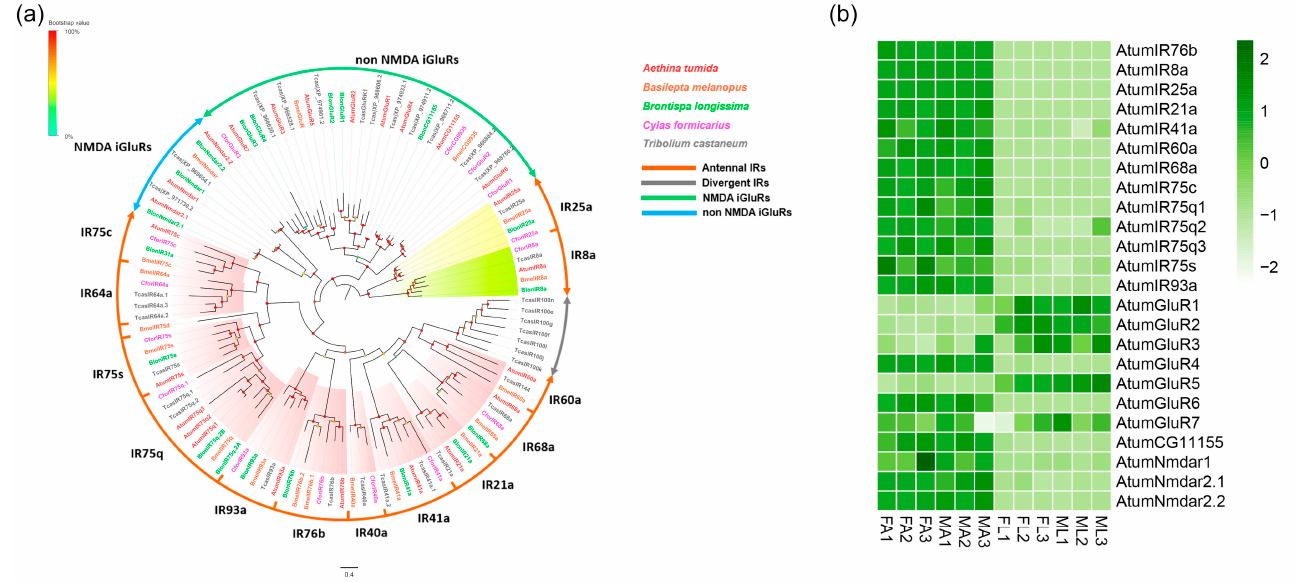
Figure 2. Analyses of putative ionotropic recptors (IRs) in A. tumida . ( a ) Maximum-likelihood tree of putative IRs. The tree was rooted with the conservative IR8a/IR25a orthologues. Circles at the branch nodes represent bootstrap values based on 1000 replicates. Scale bar represents the 0.4 amino acid substitutions per site. Antennal IRs are marked with orange; Divergent IRs are marked with gray; NMDA iGluRs are marked with green; non-NMDA iGluRs are marked with blue. ( b ) Heatmap of IRs based on antennae and forelegs transcriptome data in A. tumida . FA, female antennae; MA, male antennae; ML, male forelegs; FL, female forelegs. The transcript abundance was measured by FPKM-values.